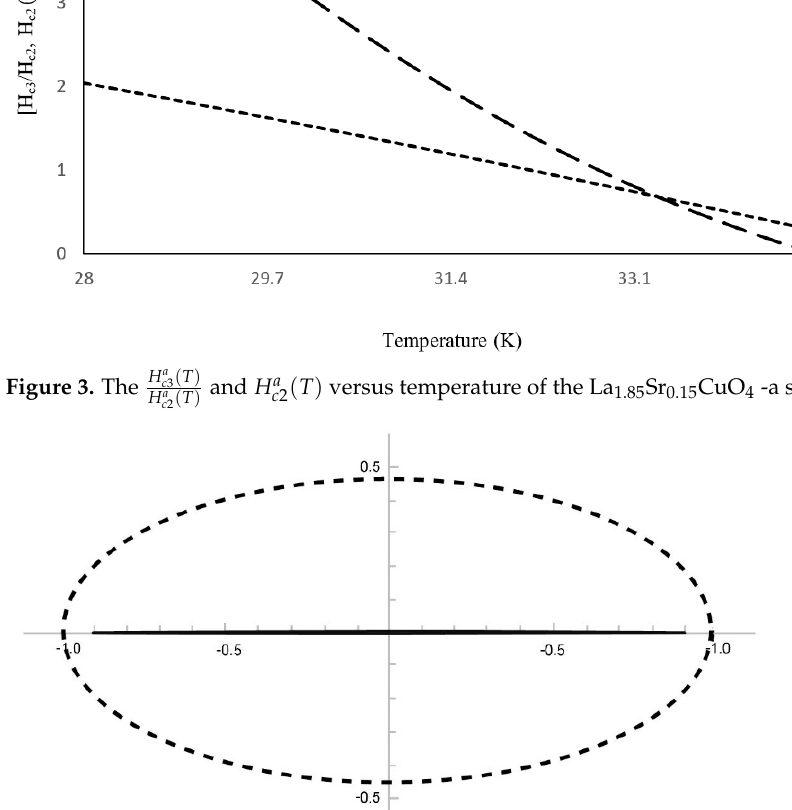
Figure 4. The anisotropic shape of the first and second bands of La 1.85 Sr 0.15 CuO 4 -a superconductor. The experimental data for the La 1.85 Sr 0.15 CuO 4 superconductor in the c-direction, LaSrCuO-c, were fitted using a second-order polynomial, and the coefficients were read out and solved using Equations (12) and (17). The parameters included